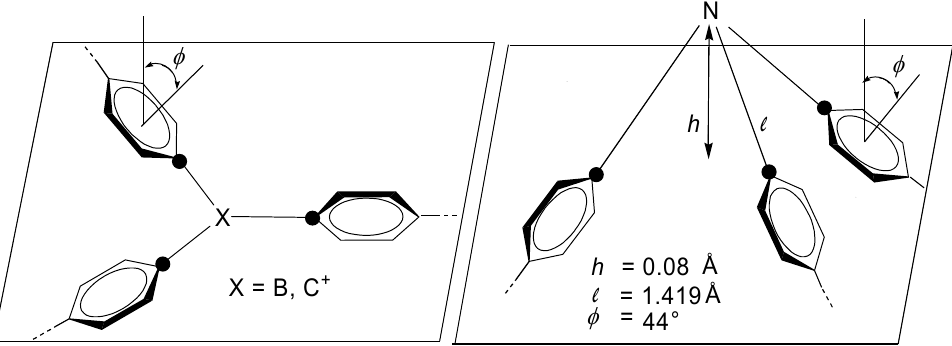
Figure 3. Molecular architecture of oligomers having C-1  C-3 cores and A-3 , A-7 or A-9 arms. The numbers in the tertiary amine structure are related to the crystal structure analysis of